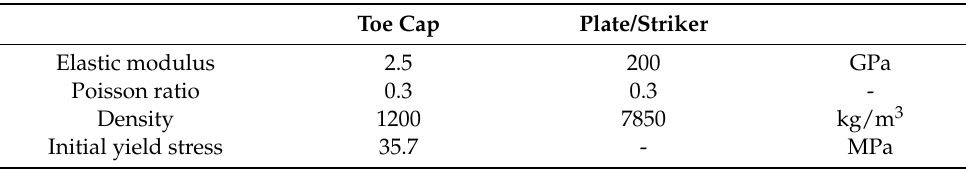
Table 5. Mechanical properties of the materials used for